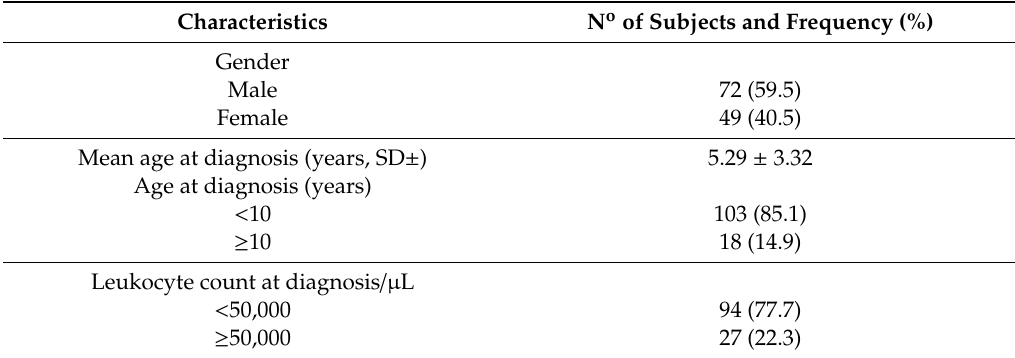
Table 2. Clinical characteristics of patients analyzed in the present